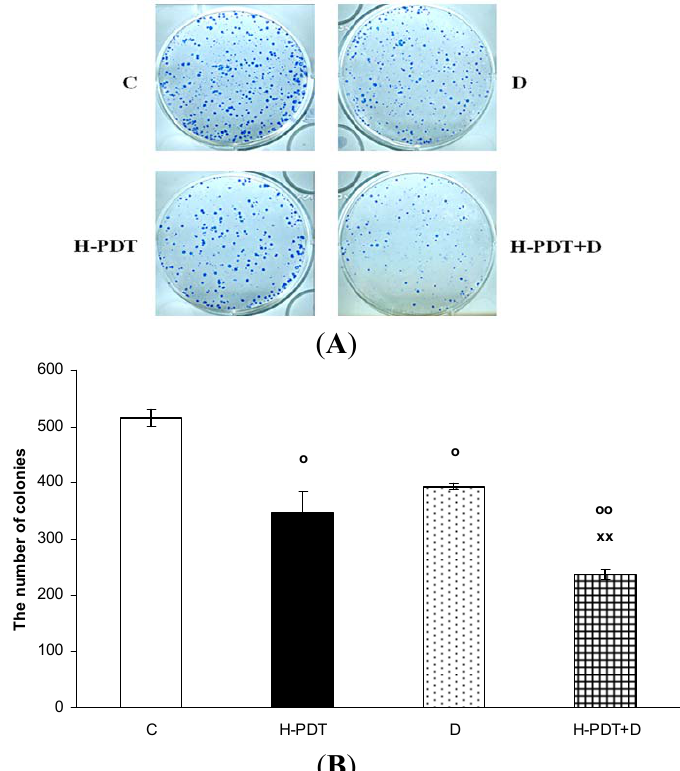
Data are presented as representative picture of colonies ( A ) and as means of colonies ± SD of three independent experiments ( B ). The statistical significance is designated as follows: H-PDT, D